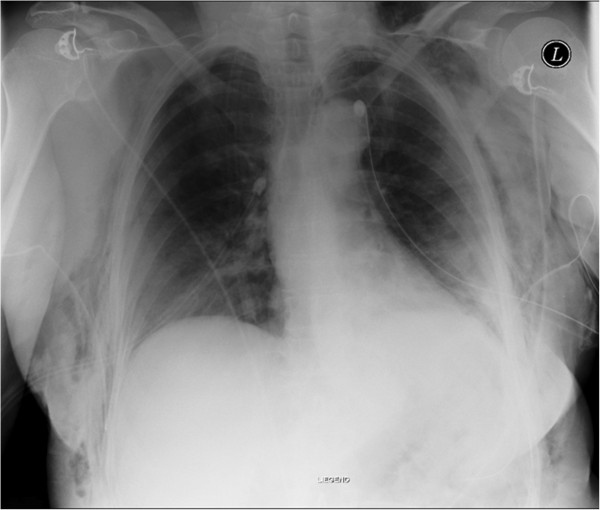
Post-tubing state.